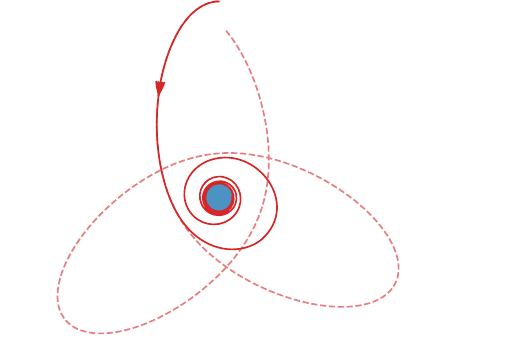
FIG. 12. Example of the orbital motion of a positively charged dust grain being further ionized and trapped in a negative-particle beam. The dashed line shows the corresponding orbit for a constant charge if no beam-dust interactions were taking place.